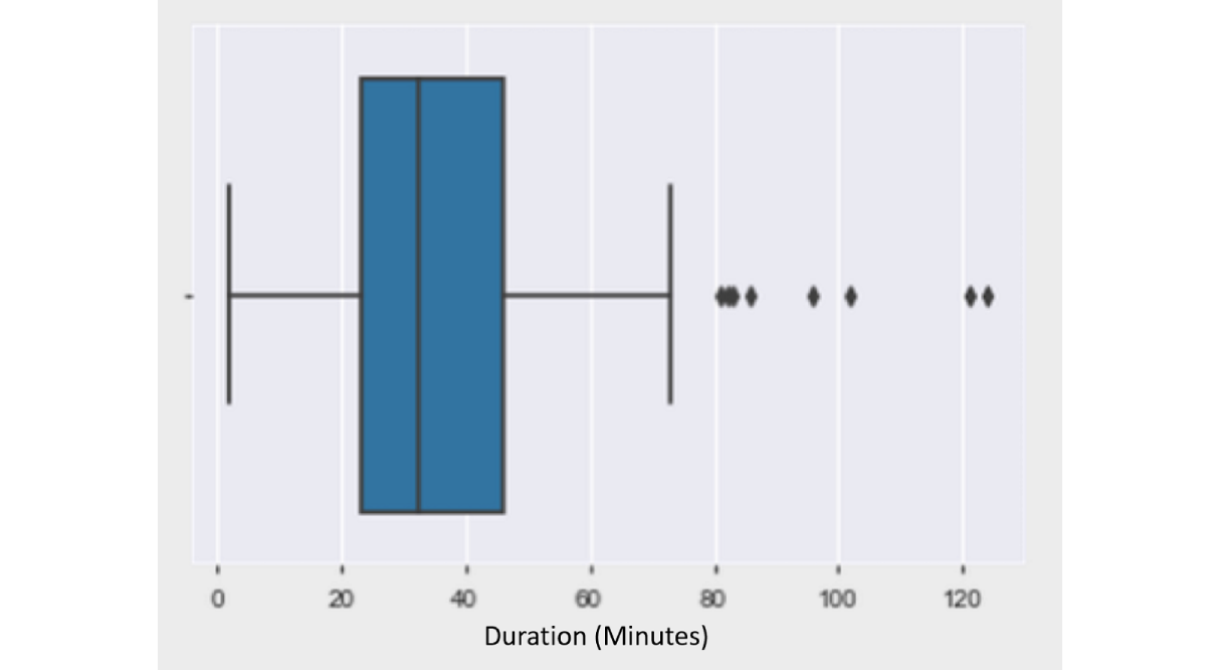
Figure 3. Box plot depicting duration of visits. Outliers are the values >80 minutes, and the average value is approximately 35